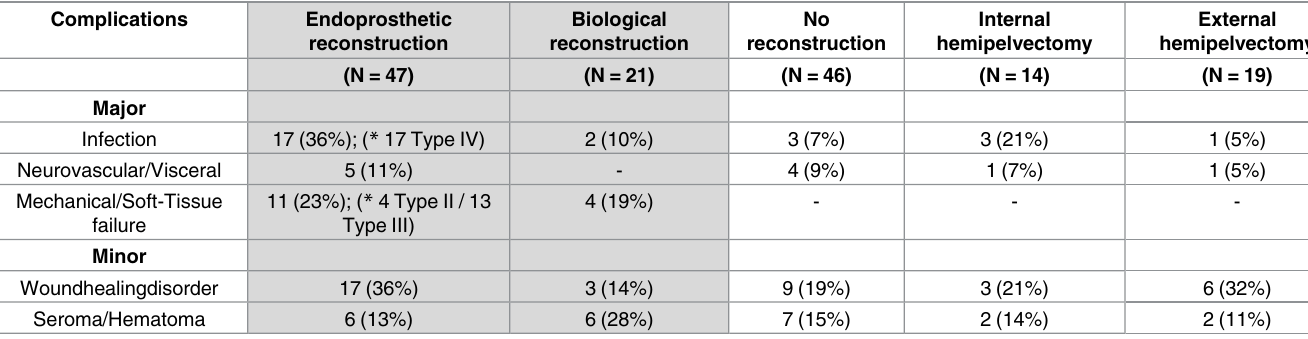
Table 4. Complications according to the type of